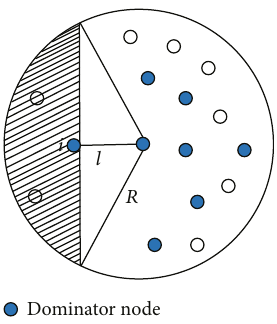
Figure 13: The structure of